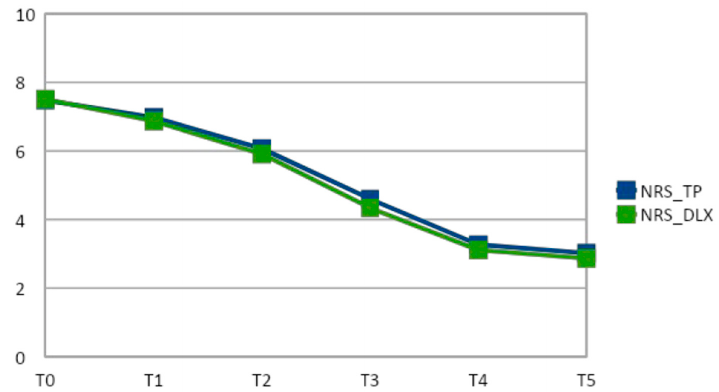
Figure 2. NRS in TP and TP plus DLX groups (x: NRS, y: time points).